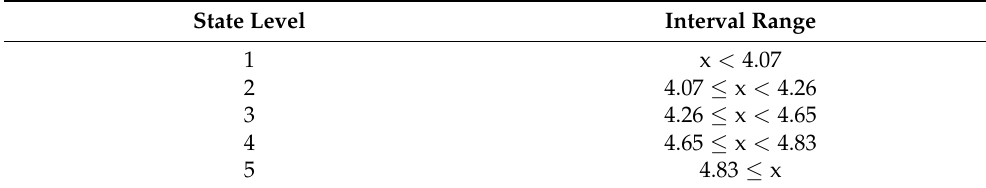
Table 5. State division of sea clutter power.